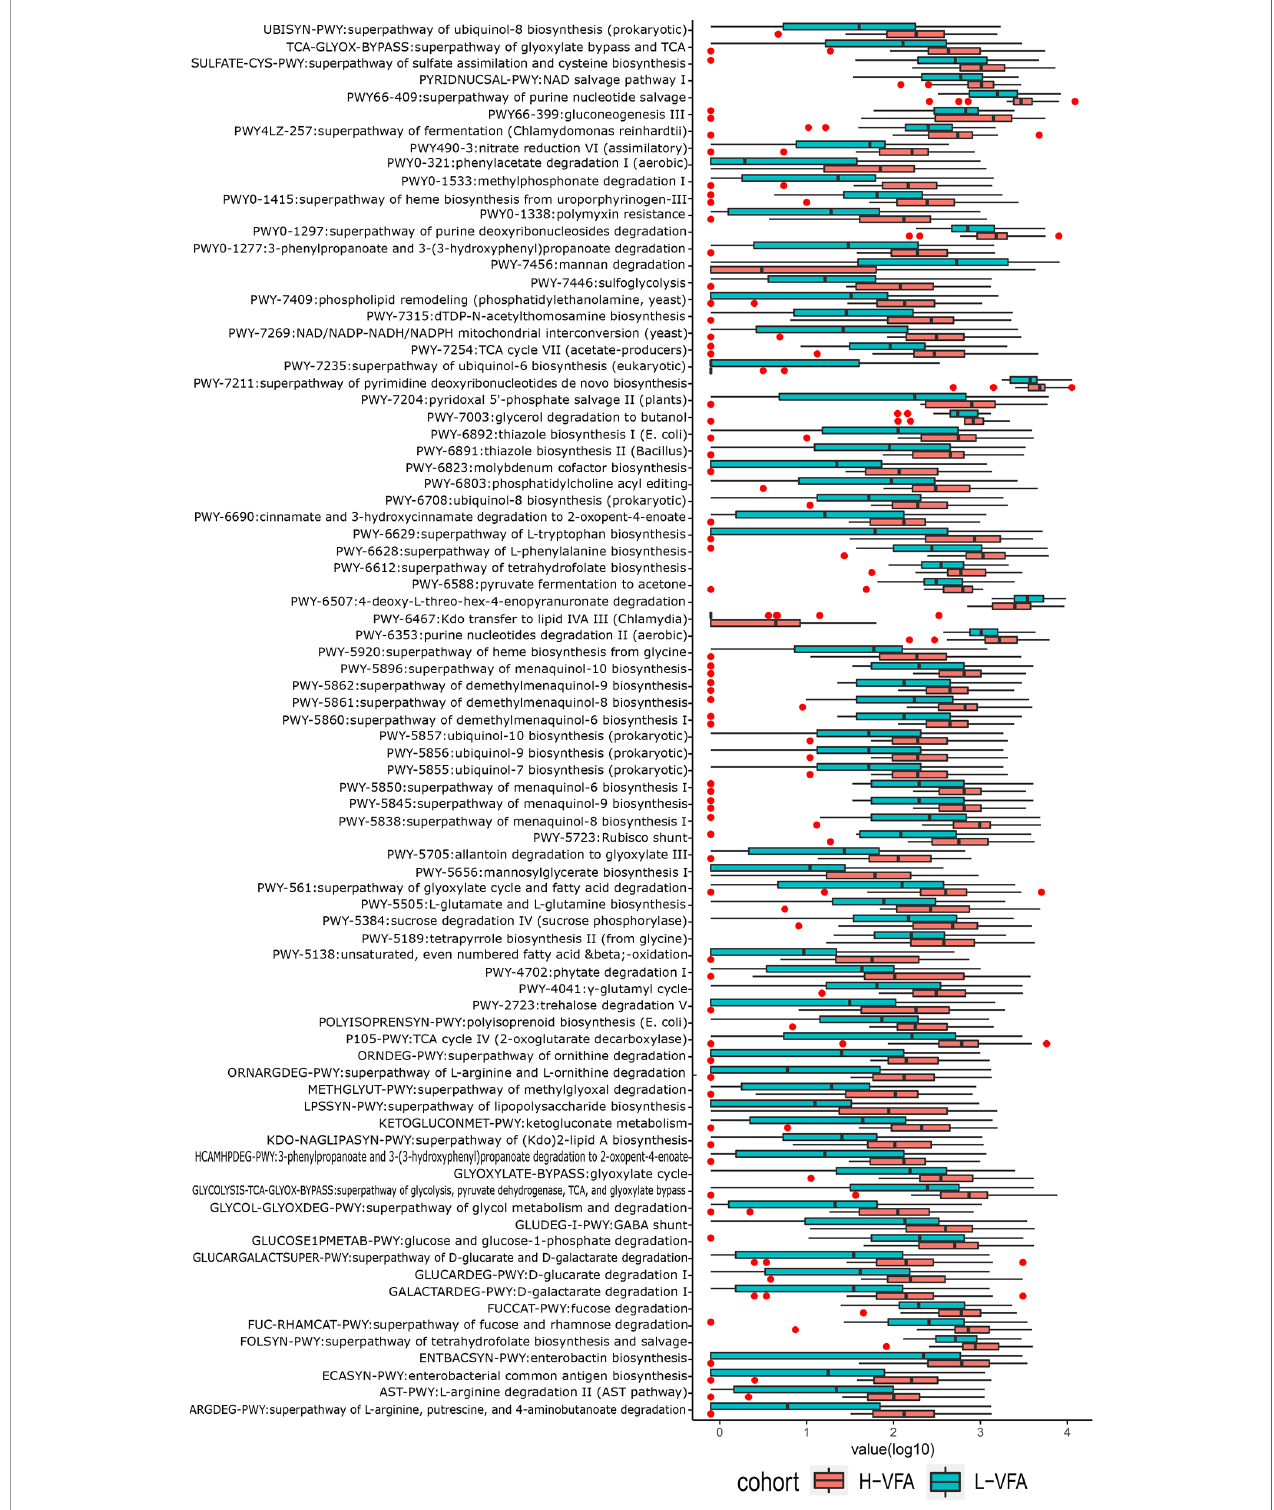
FIGURE 3 | The functional shifts of bacterial species between the H-VFA group and the L-VFA group. Eighty-three pathways were signi fi cantly different between the two groups, and 80 enriched the H-VFA subjects. Within the 80 H-VFA enriched pathways, 24 ways were responsible for the degradation of short-chain fatty acids, production of lipopolysaccharides, and metabolism of carbohydrates, fatty acids, lipids, and amino acids.